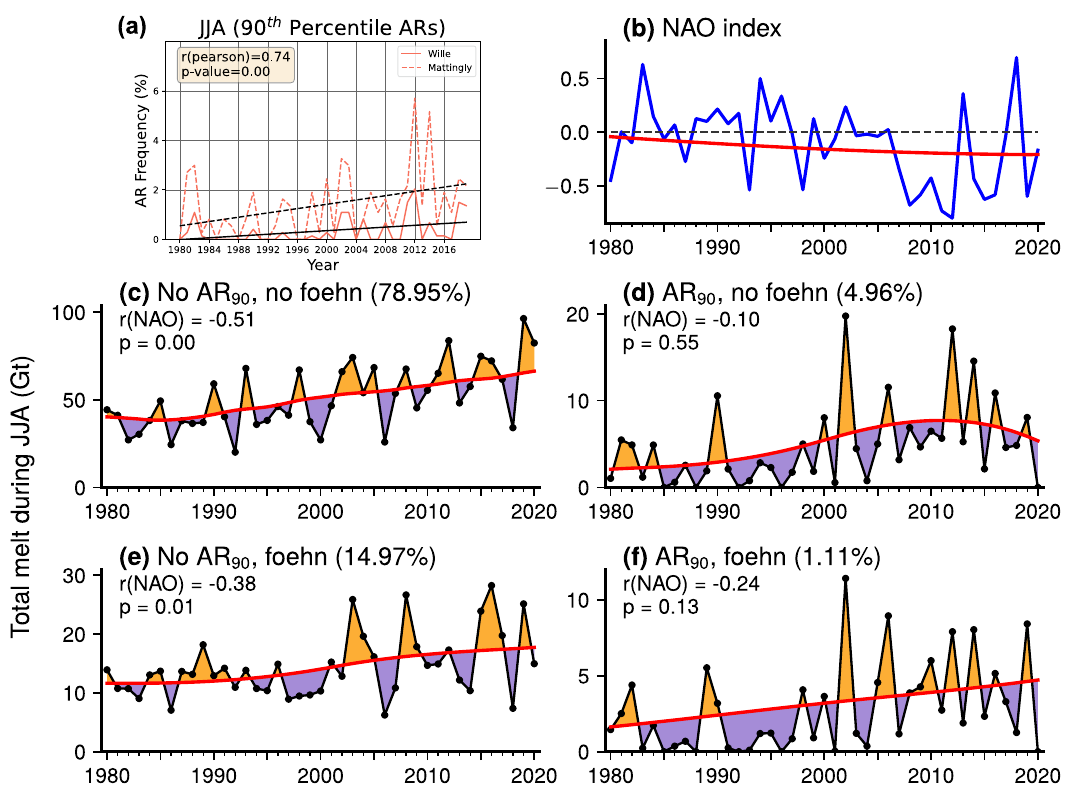
Fig. 6 | Northern Greenland summer (JJA) atmospheric river (AR) and foehn timeseries.a JJAARfrequencytrendsinnorthwest(NW)Greenland(orangeboxin Fig. 1a) for ARs exceeding the 90th intensity percentile (AR 90 ) (from monthly cli- matological integrated water vapor transport (IVT) during 1980 – 2020) according to the ARdetectionalgorithms inrefs. 21,31 , with lineartrend fi t superimposed. b JJA mean North Atlantic Oscillation (NAO) index during 1980 – 2020, with nonlinear curve fi t using the Ensemble Empirical Mode Decomposition (EEMD) method (red line).TimeseriesoftotalJJAmelt(Gt)fromthepolarRegionalAtmosphericClimate Model version 2.3p2 (RACMO2) integrated across all grid cells in northeast (NE)